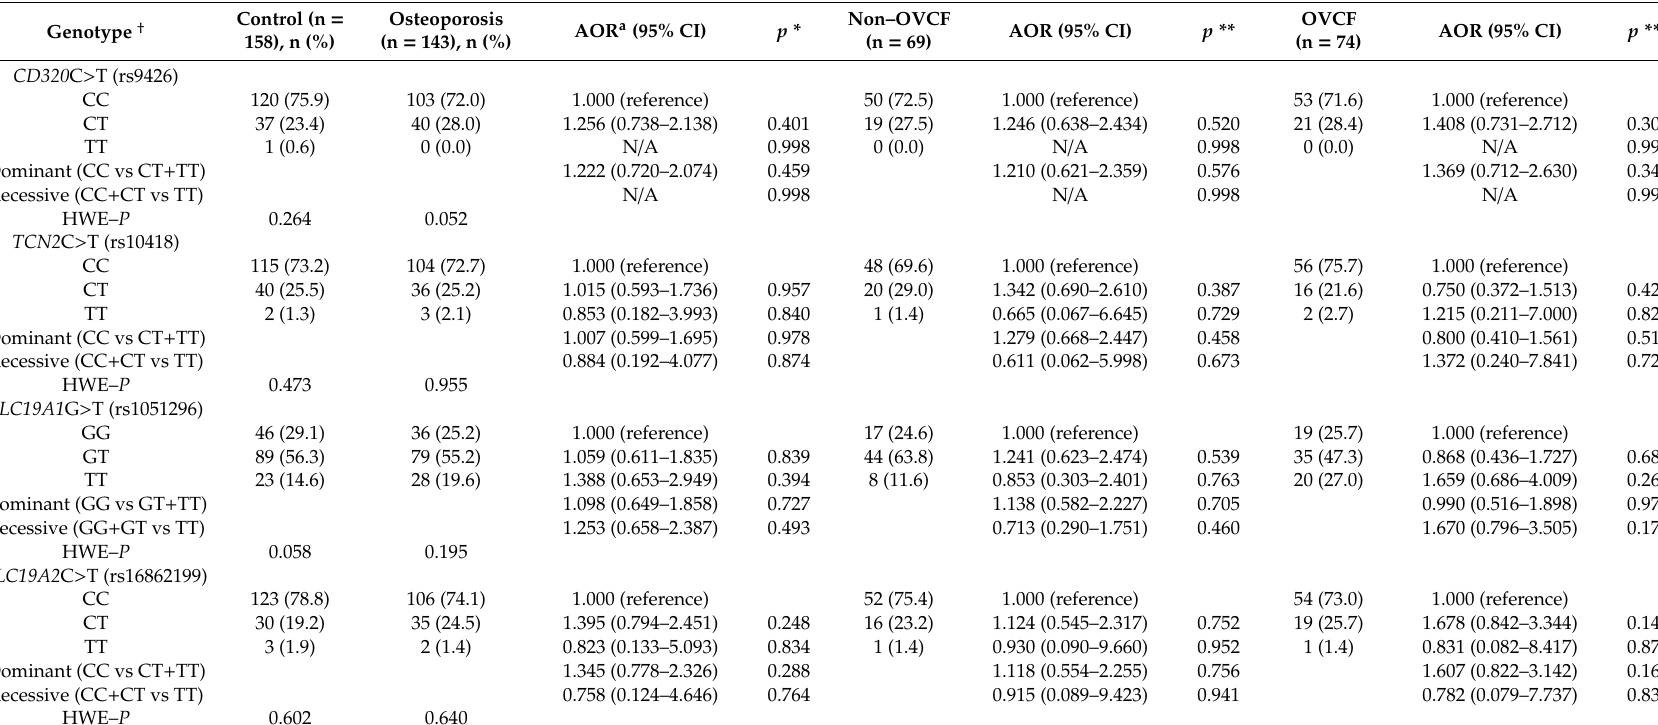
Table 2. Genotype frequencies for the 3’-UTR polymorphisms of CD320, TCN2, SLC19A1 and SLC19A2 genes in control and OVCF